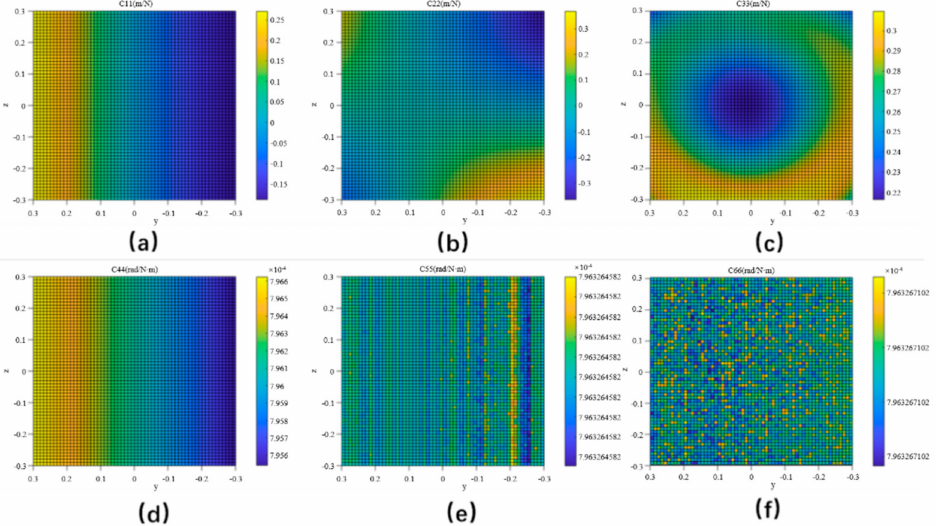
Figure 5. Flexibility matrix elements plane: ( a ) C 11 ( b ) C 22 , ( c ) C 33 , ( d ) C 44 , ( e ) C 55 , and ( f ) C 66